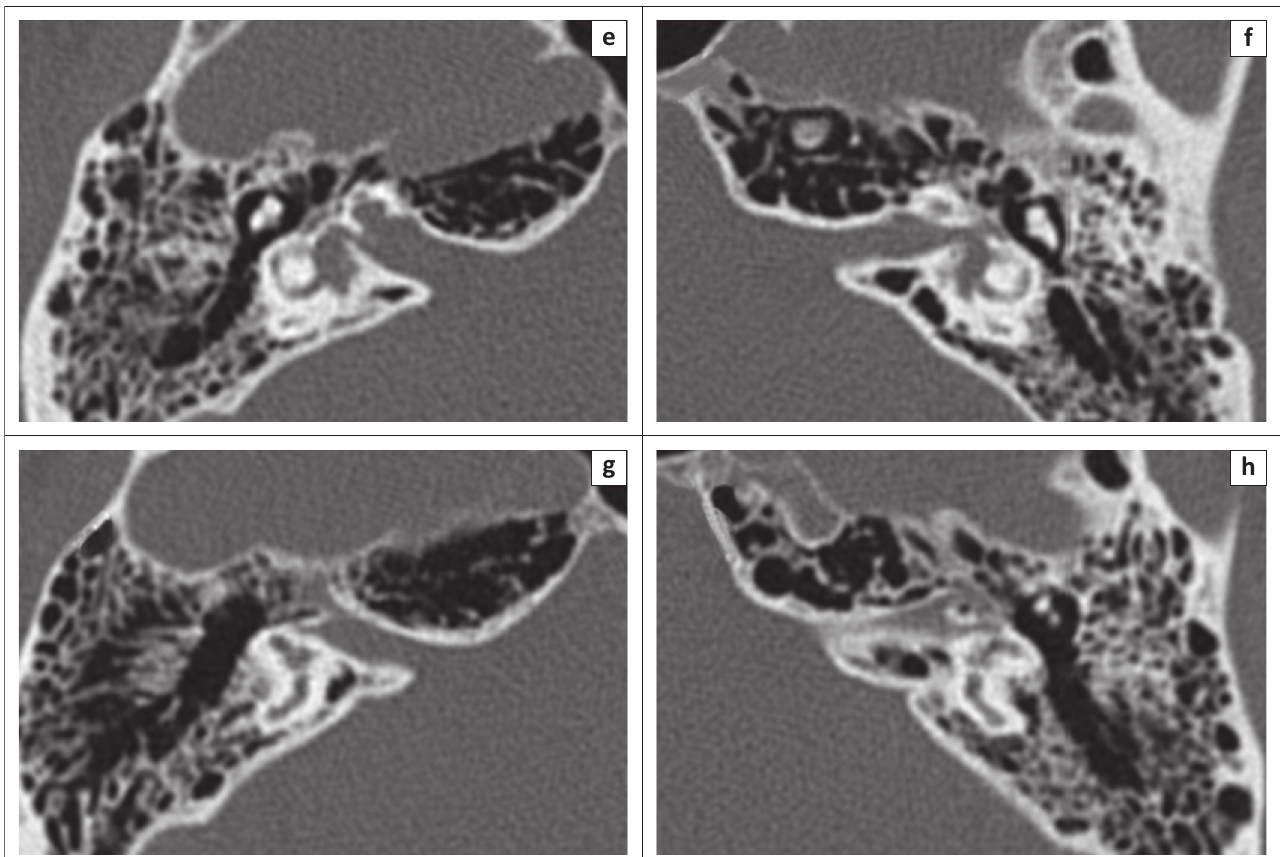
FIGURE 1 (Continues...): Axial images through the right (panel a, c, e and g) and left (panel b, d, f and h) petrous bone.